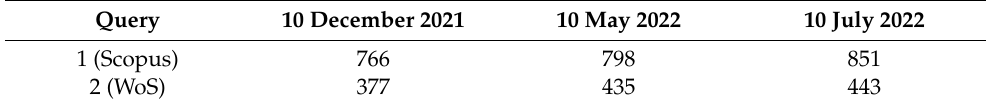
Table 1. Queries dynamics results in indicated time points.